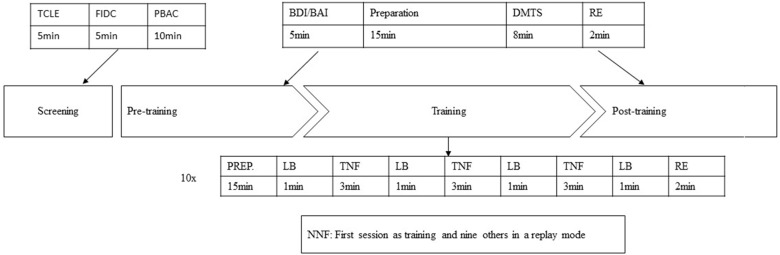
Protocol description of pre- and post-training for the NF and SNF. (1) TCLE, Brazilian free form of consent to participate in research; (2) FIDC, Record of Clinical and Demographic Information; (3) PBAC, Philadelphia Brief Assessment of Cognition; (4) BDI/BAI, Beck Depression and Anxiety Inventory; (5) DMTS, Delayed Matching to Sample Task; (6) Baseline; (7) NF, neurofeedback training; (8) SNF, sham neurofeedback training.